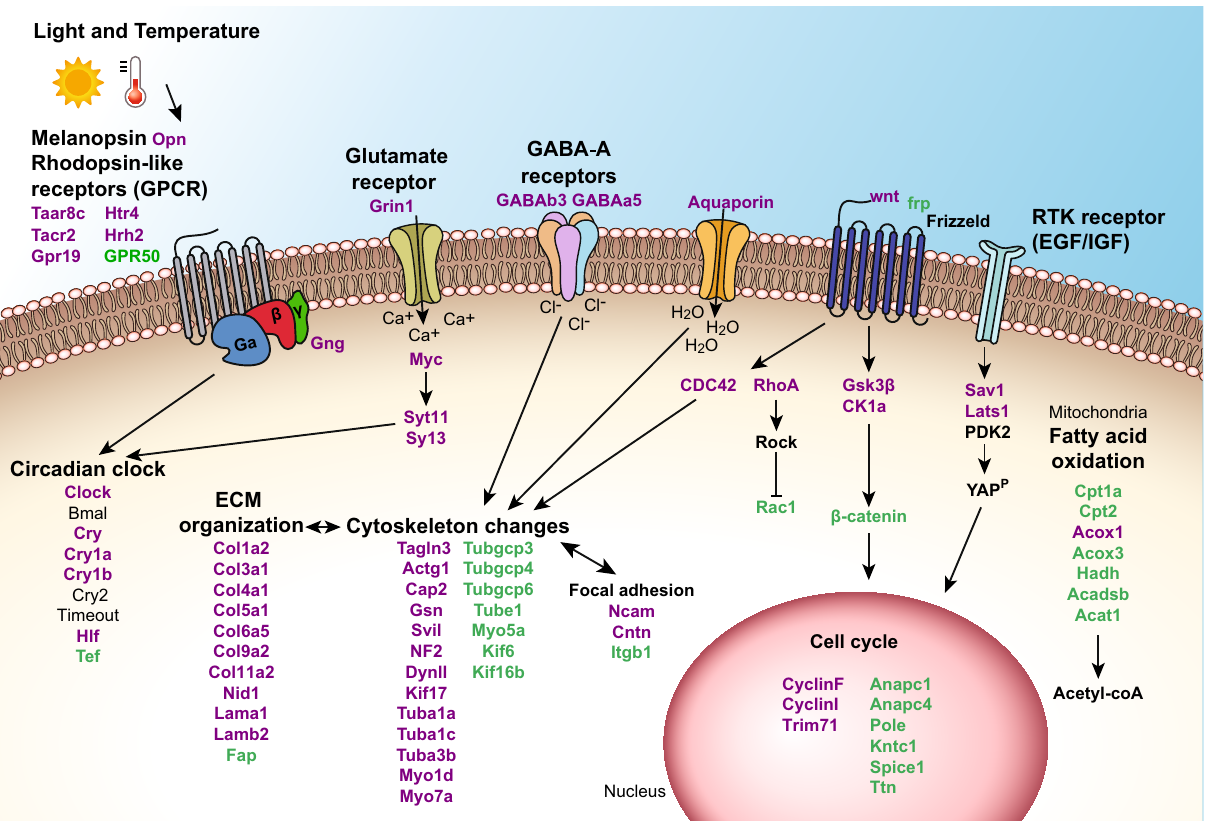
Figure 4. Proposed model for molecular signaling during spawning induction in Nematostella vectensis . The process is triggered by light and temperature elevation. We propose that light stimulates melanopsin- like homologue, which activates rhodopsin and glutamate receptors and initiates GPCR signaling cascades. Other receptors are also activated and together they affect cell cycle, cytoskeleton and ECM organization, focal adhesion, fatty acid oxidation, and circadian clock components. Eventually, these processes lead to successful spawning. Upregulated transcripts are written in purple and downregulated transcripts are in